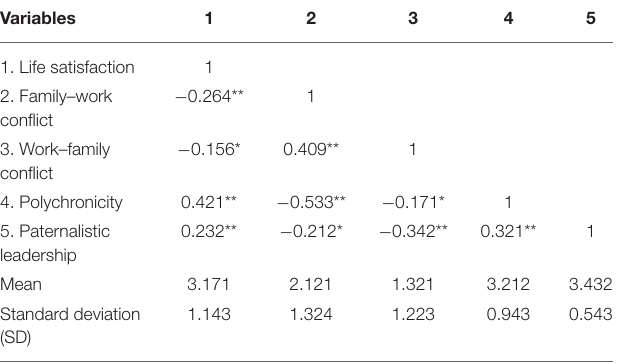
TABLE 2 | Means, standard deviation, and correlations. TABLE 3 | Factor loading, Cronbach’s α , composite-reliability score, and